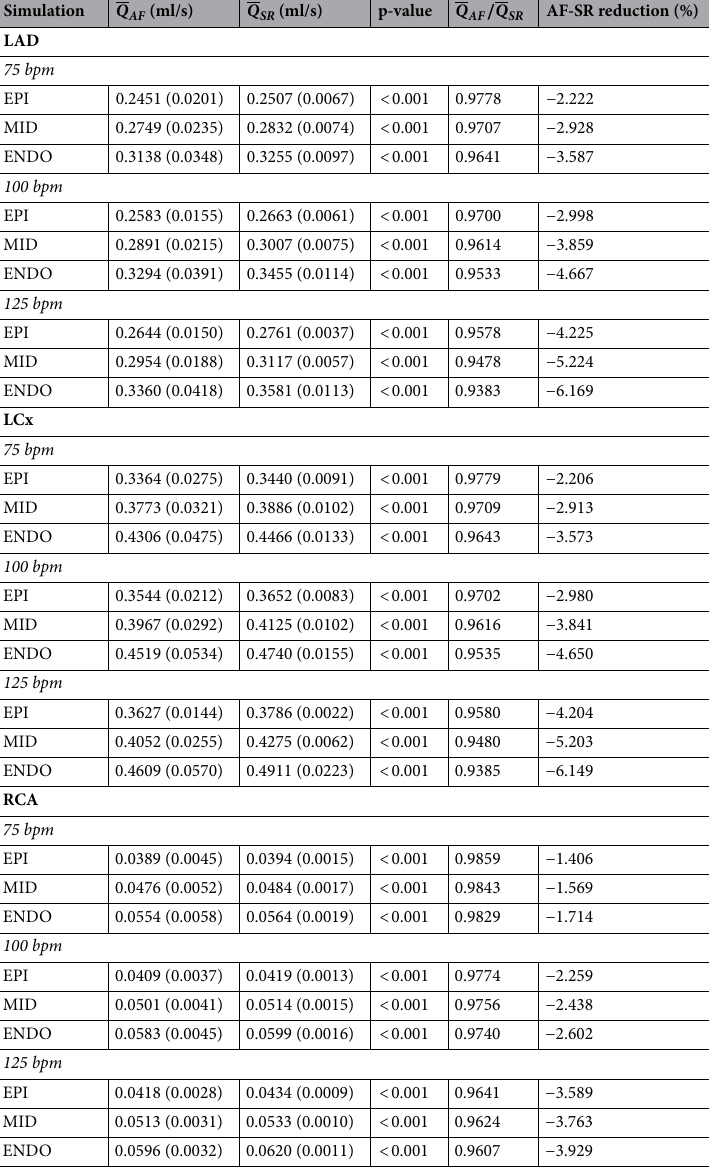
Table 1. Beat-to-beat analysis reporting mean Q AF , Q SR , Q AF / Q SR for each simulation, stratified by myocardial layers. LAD left anterior descending artery, EPI subepicardium, MID midwall, ENDO subendocardium, LCx left circumflex artery, RCA right coronary